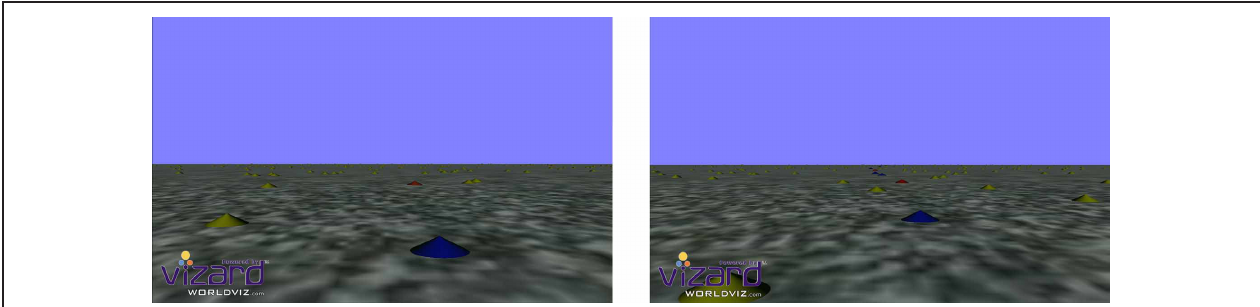
FIGURE 1 | Screen shots for both the Steer/Head Nr trials (left) and Steer/Head Pv trials (right). Trials stimulus was interspersed with a screen the same color as the sky with a central cue indicating whether participants should respond to heading or actively